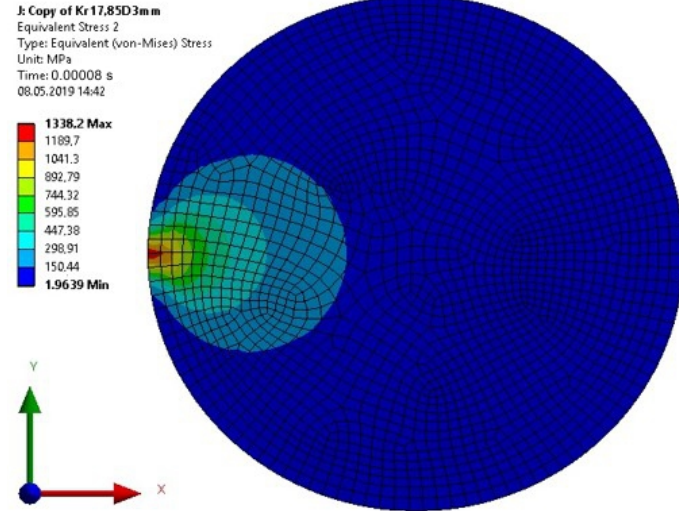
Figure 16. The von Mises Stress in the upper element of the specimen for a computation time equal to 0.00008 s—Model no. 2 (linear analysis). The loads are applied in the direction of the X axis.